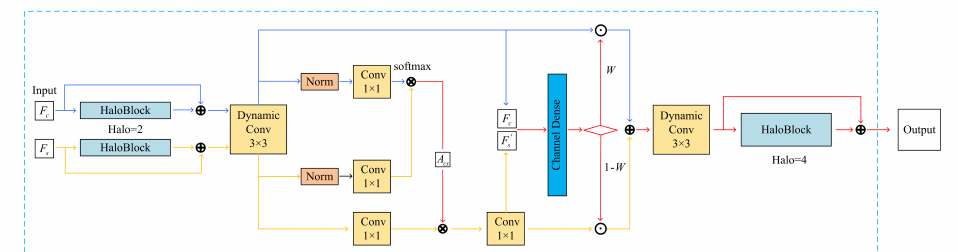
Figure 3. HDAMA block structure figure . Input feature maps F c and F s , features are extracted by the halo attention and dynamic convolution modules; then, manifold alignment operation occurs, and finally features are output by dynamic convolution and halo attention